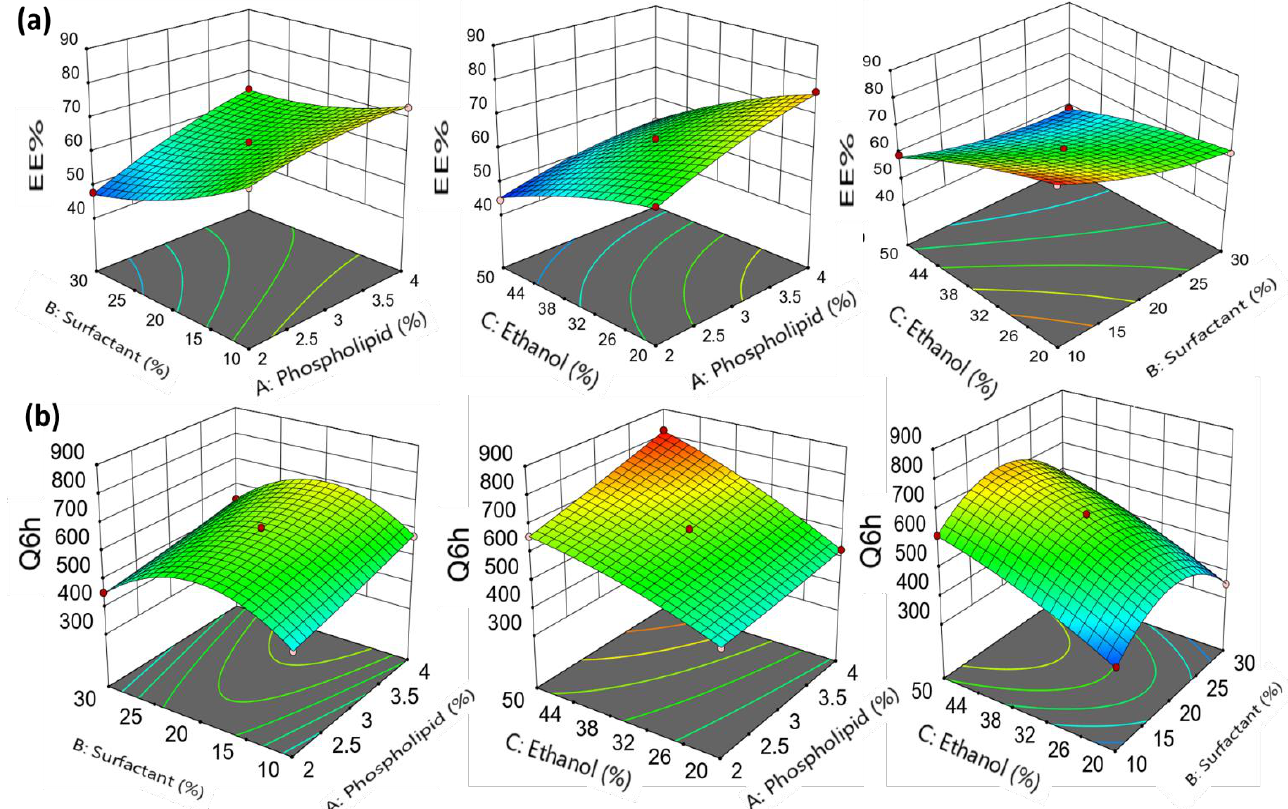
Figure 1. 3D-response surface plot showing the effect of independent variables on ( a ) Entrapment efficiency (Y 1 ) and ( b ) Cumulative amount of drug permeated after 6 h (Q6h) (Y 2 ).